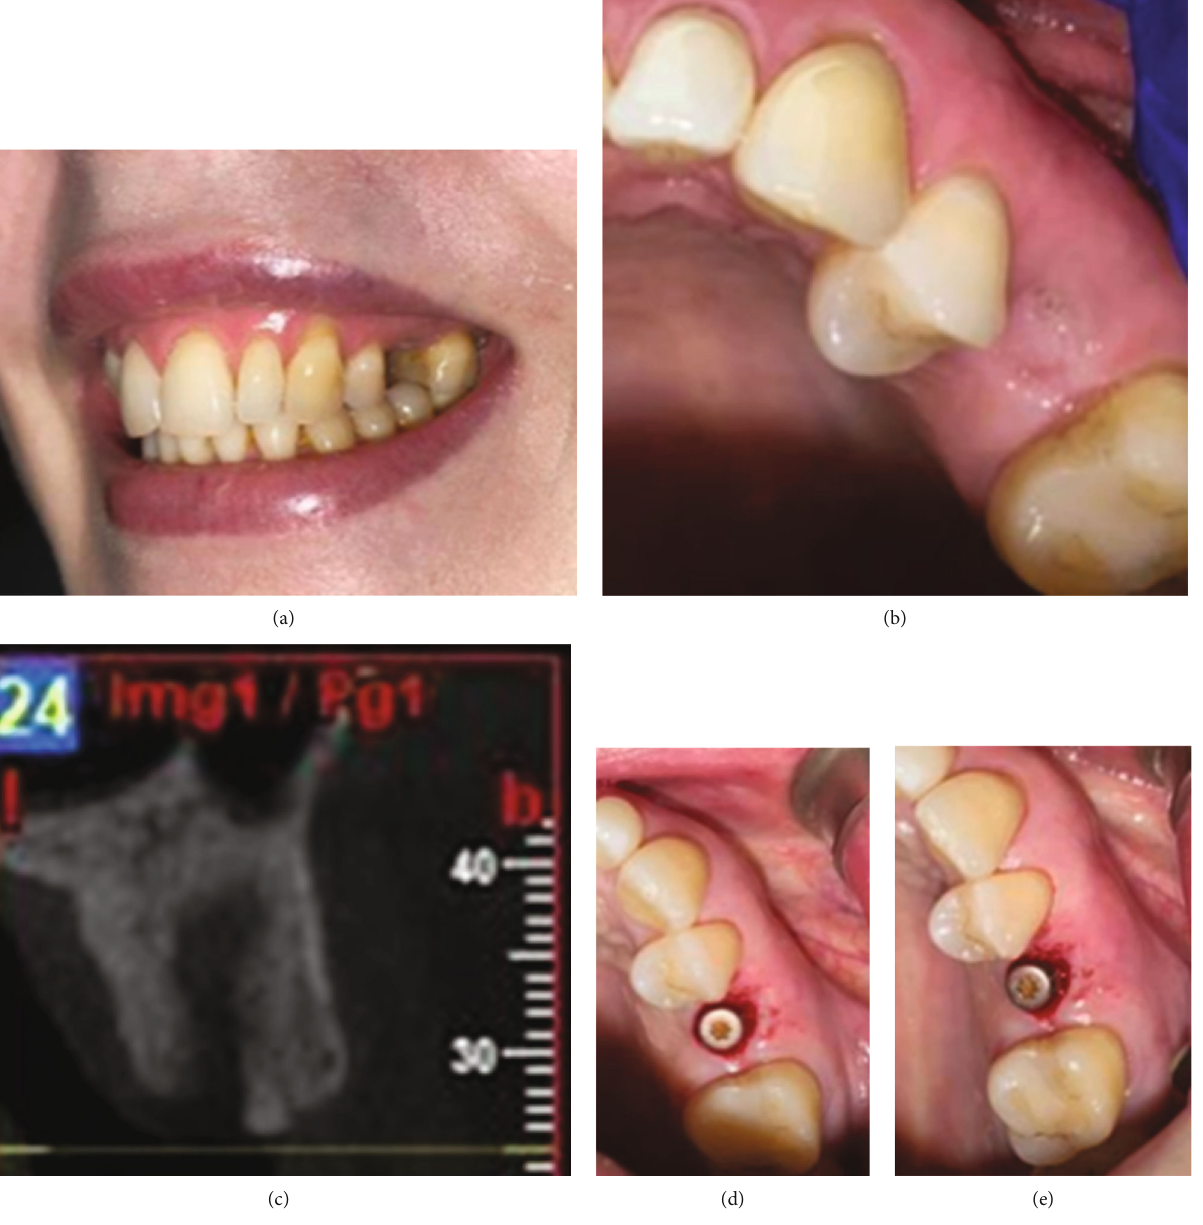
Figure 2: Lateral view upon smiling (a), occlusal view of extraction site of tooth 25 after 8 weeks (b), B – P radiographic section with root fragment in situ (c), and occlusal and buccal views of the healing abutment and remaining root shield immediately following implant placement (d and